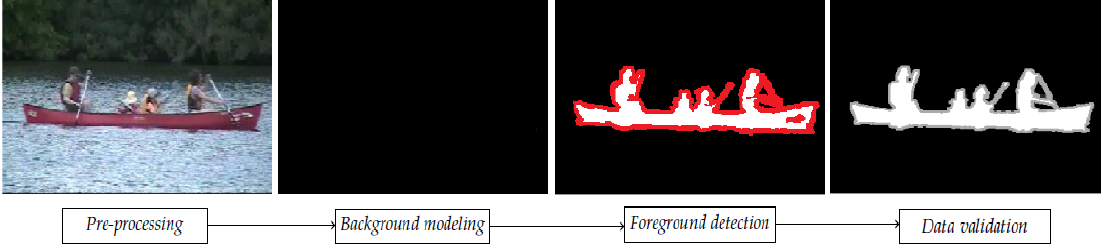
Figure 1. Diagram of a generic background subtraction algorithm illustrated with the video Canoe, from the video category Dynamic background (from the site